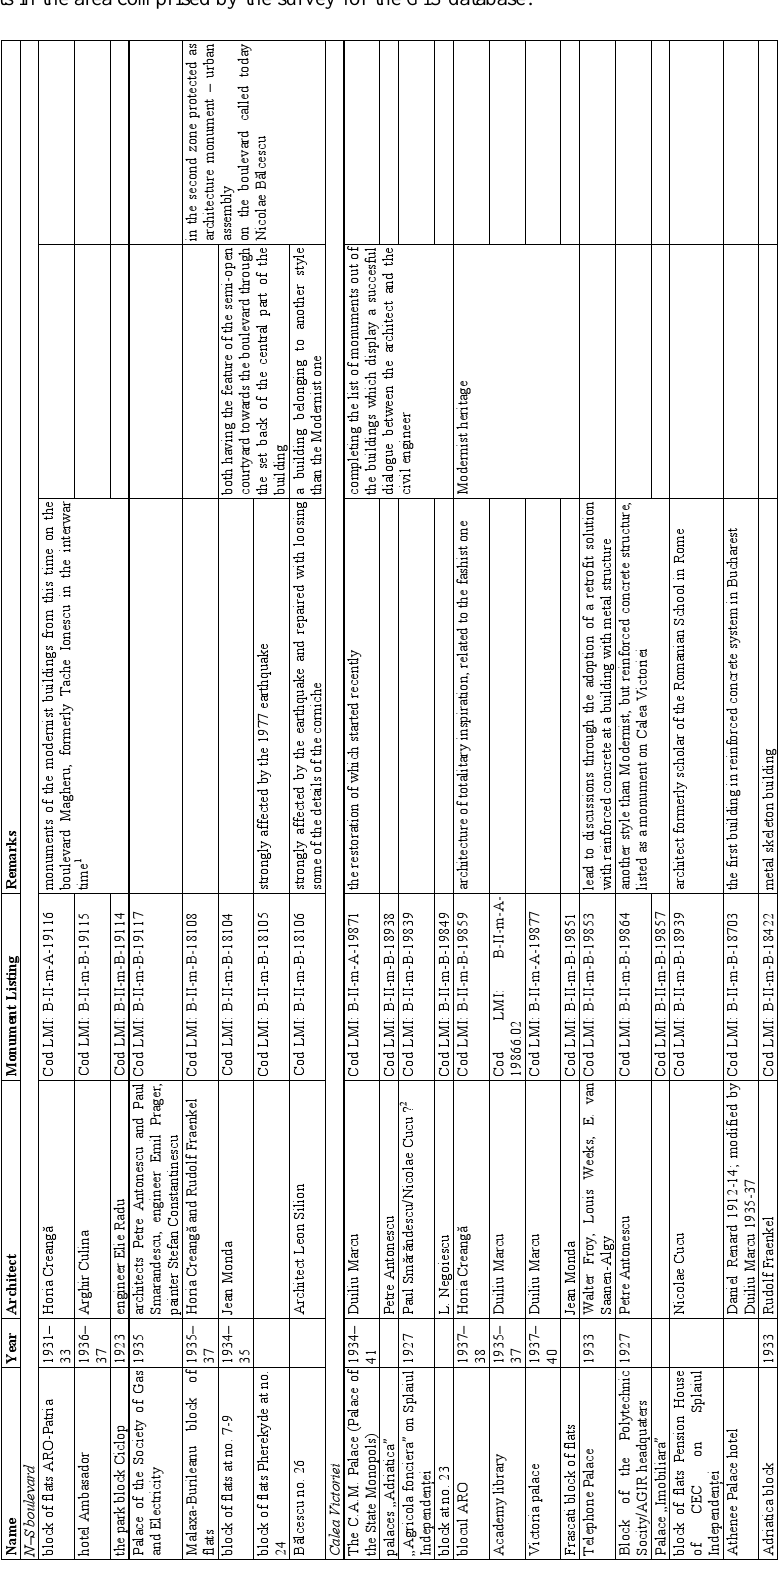
Table 3. List of monuments in the area comprised by the survey for the GIS